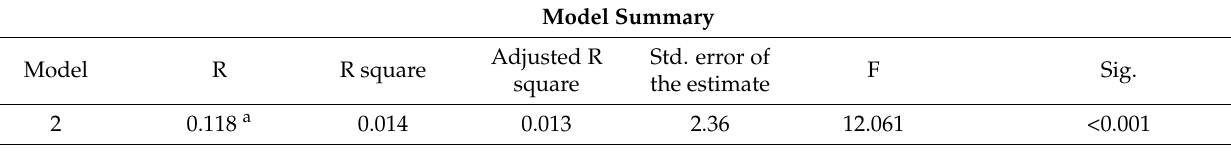
Table 5. Regression analysis for total knowledge